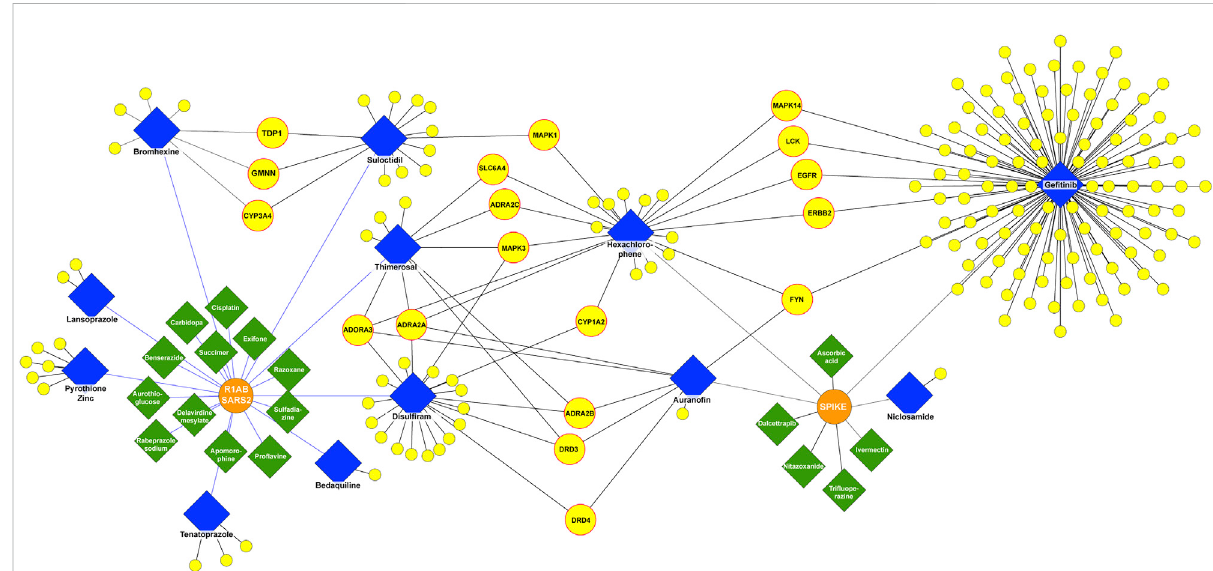
FIGURE 3 DPI subnetwork. Human and viral proteins are shown as yellow and orange circles, respectively. Drugs that interact only with viral targets are shown as green diamonds and drugs that interact with both viral and human targets as blue diamonds. Yellow circles with a red border represent human proteins interacting with at least two drugs, which also interact with one or more viral proteins.